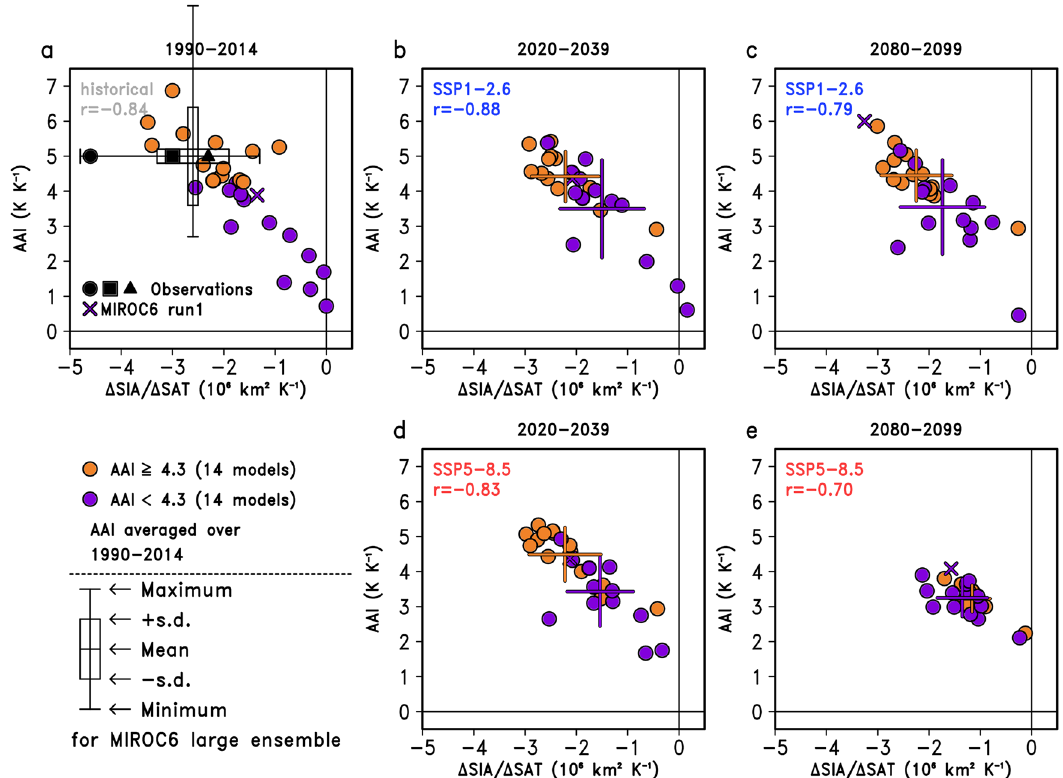
Fig. 5 Relationship between sea-ice reduction and AAI in the CMIP6 multimodel ensemble. a – e Scatter plots of the OND-mean AAI (K K − 1 ) against the JAS-mean SIA change scaled with the global-mean SAT change (10 6 km 2 K − 1 ) for ( a ) 1990 – 2014, ( b , d ) 2020 – 2039, and ( c , e ) 2080 – 2099. Results from ( b , c ) SSP1-2.6 and ( c , e ) SSP5-8.5 simulations are shown separately. The black closed circle, square and triangle in ( a ) denote observations 41 – 44 , in